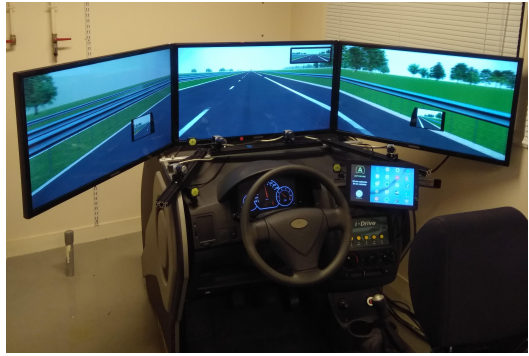
Figure 1: Driving simulator environment